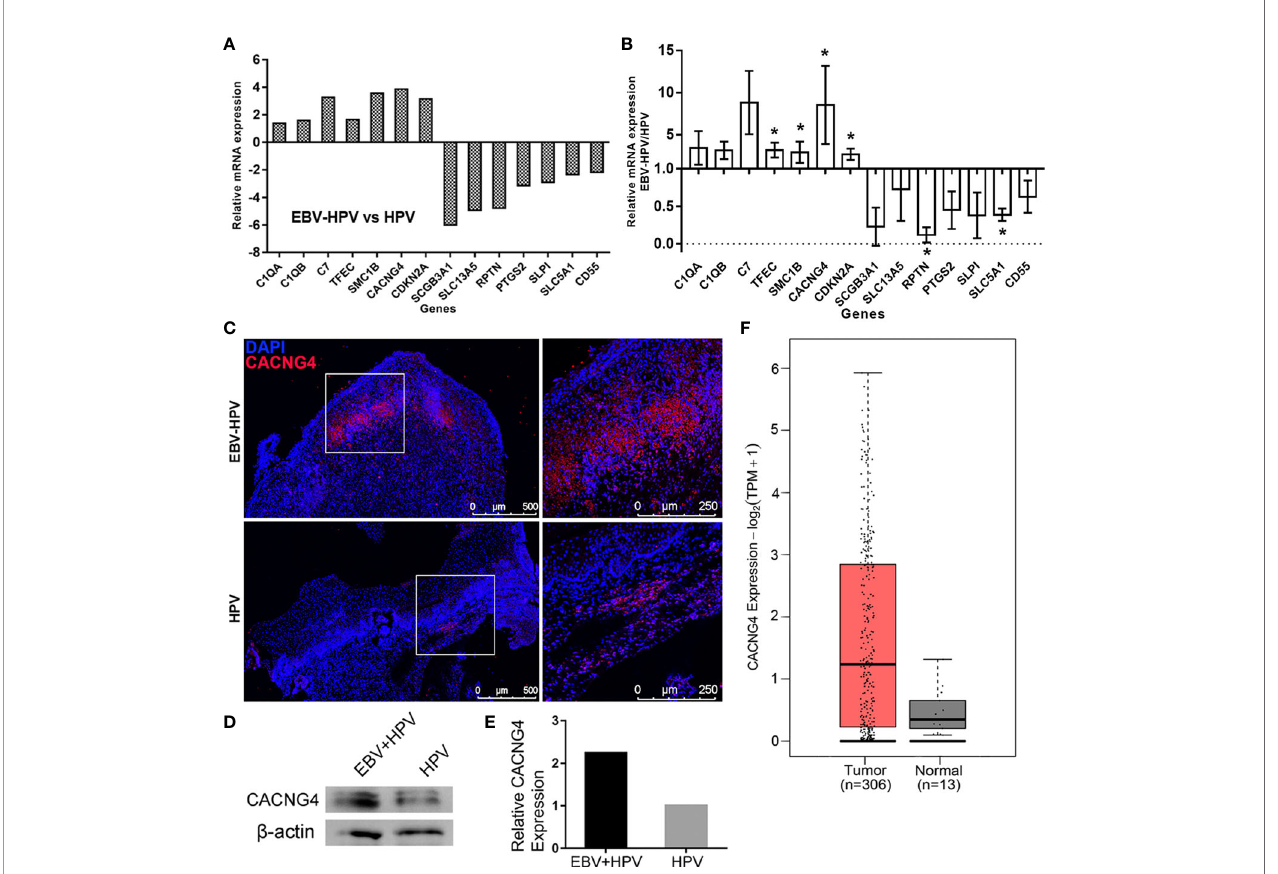
FIGURE 4 | Selected mRNAs with signi fi cant changes and overexpression of CACNG4 in EBV-HPV-associated CIN lesions. Expression levels of the selected, signi fi cantly altered mRNAs of the mRNA-seq analysis (A) and RT-PCR validation (B) . Each value was normalized to the GAPDH value and is presented as the mean ± SD, * p <0.05, compared with the HPV group. (C) A red fl uorescence signal indicating the presence of CACNG4 was detected in cervical tissues. (D) Protein expression of CACNG4 relative to b -actin expression in cervical tissues. (E) Densitometric analysis of the immunoblots. The intensity of each band was normalized to the b -actin intensity. Due to the limited amount of clinical material, the EBV-HPV sample consisted of 4 pooled biological replicates and the HPV sample consisted of 3 pooled biological replicates in (D, E) . (F) The expression of CACNG4 between cervical cancer samples and normal tissue samples taken from TCGA and the GTEx databases. TPM, transcripts per